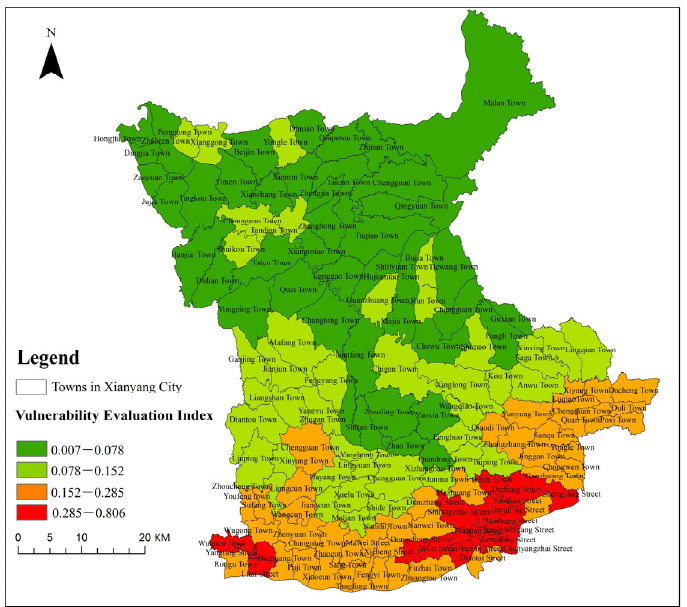
Figure 10. Landslide vulnerability evaluation index of Xianyang City.